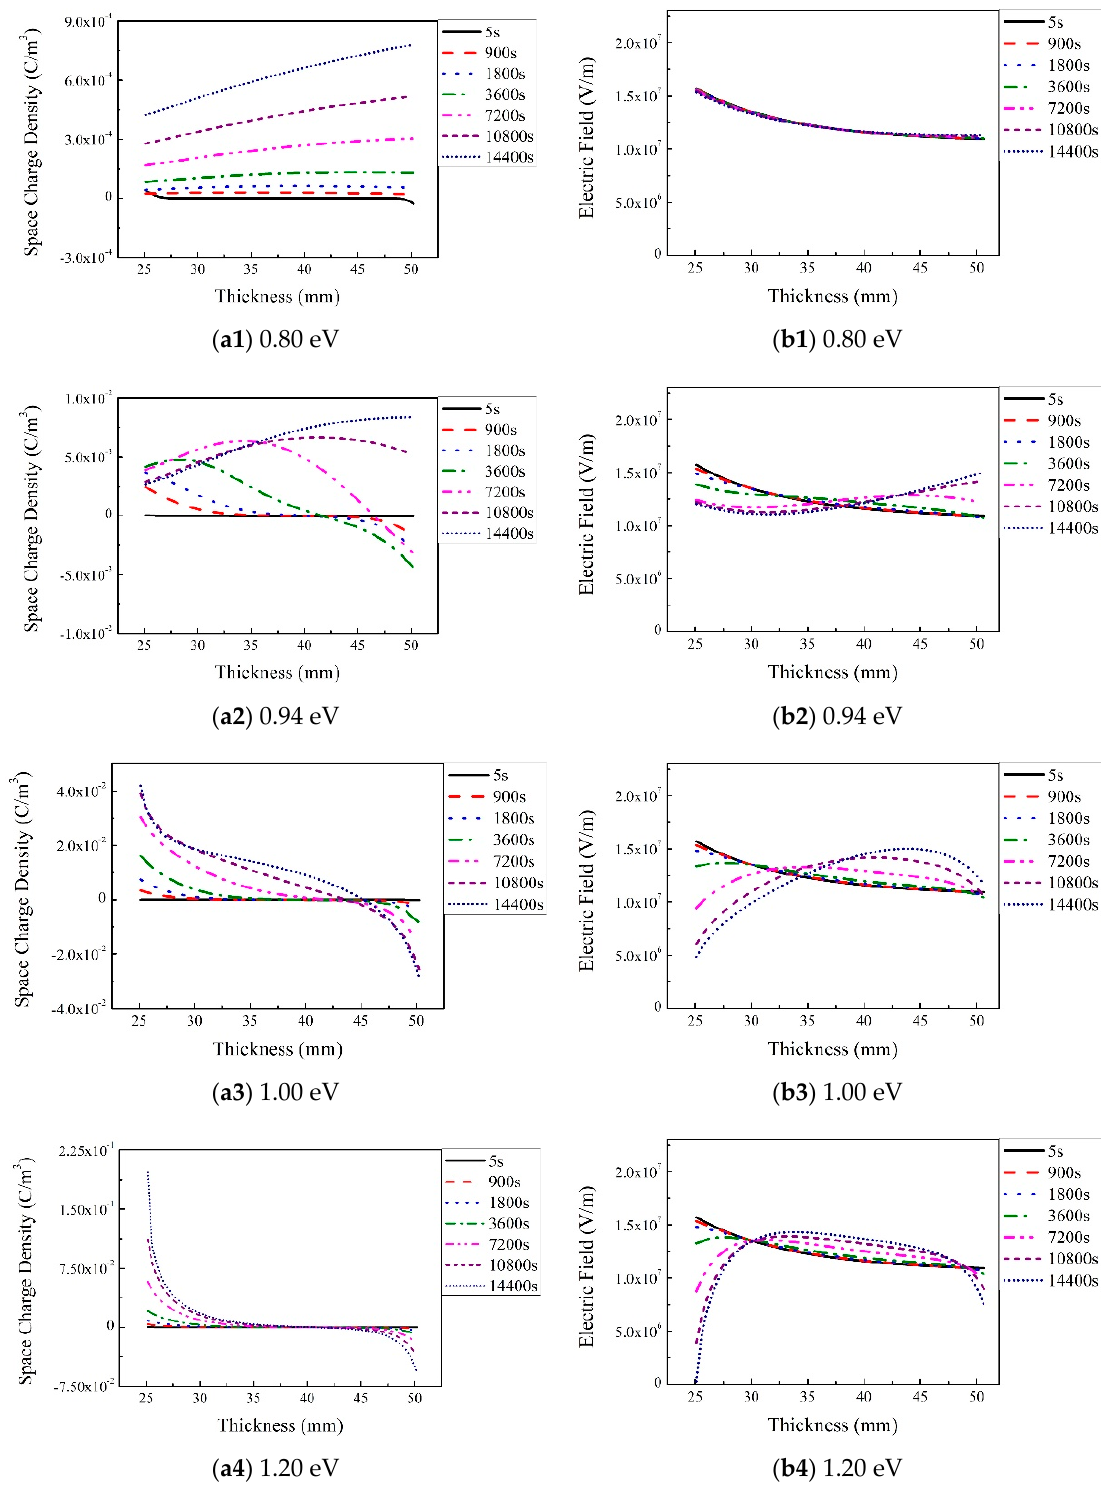
Figure 3. Simulation results of space charge distribution ( a1 – a4 ) and electric field distribution ( b1 – b4 ) in 320 kV HVDC cable insulation when the trap depth varies from 0.80 to 1.20 eV with the trap density of 80 × 10 19 m − 3 and load current of 1800